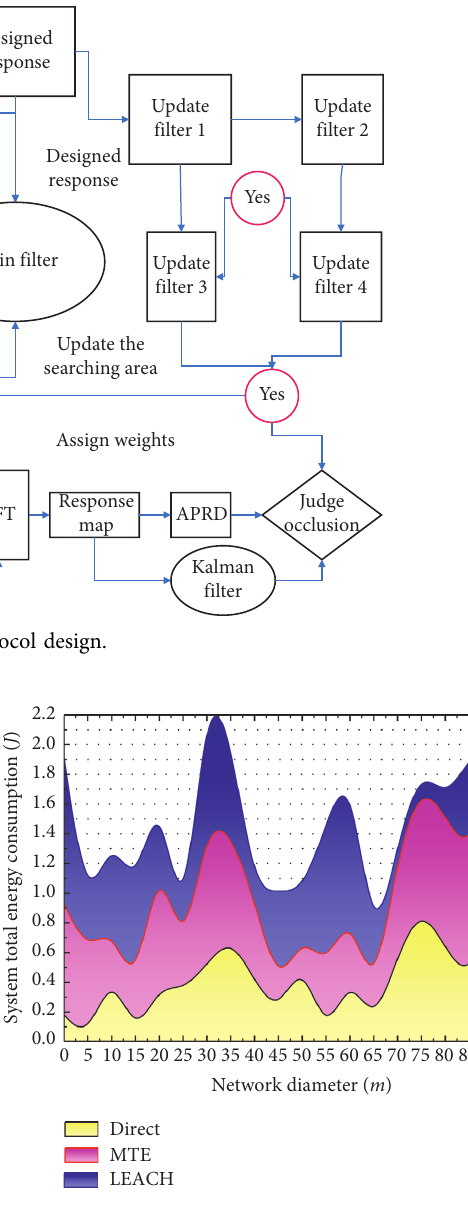
5: Total system energy consumption versus network